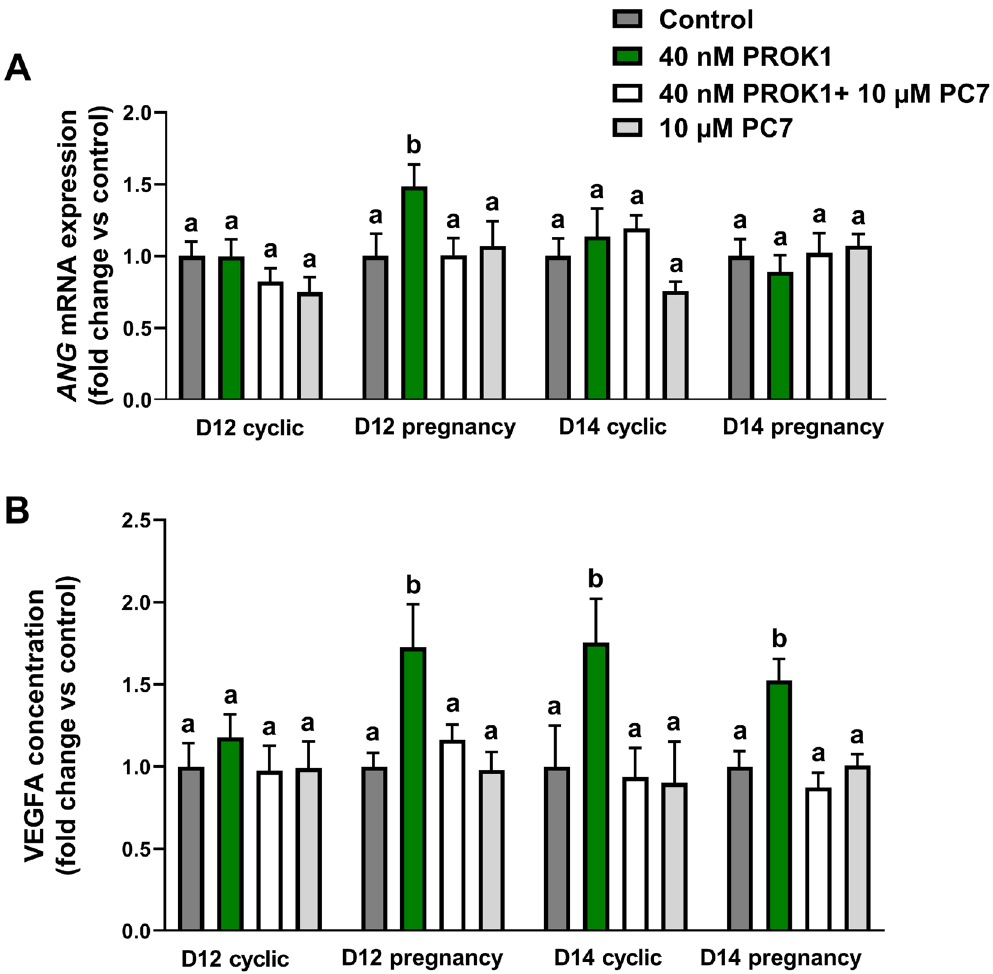
Figure 7. The effect of prokineticin 1 (PROK1) on ( A ) mRNA expression of angiogenin ( ANG ) and ( B ) on vascular endothelial growth factor A (VEGFA) secretion. Precision-cut luteal slices were incubated with control (vehicle) or PROK1 (40 mM) for 18 h in the presence/absence of prokineticin receptor 1 (PROKR1) antagonist (PC7; 10 µM). Data are presented as means ± SEM. Different lowercase letters (a, b) indicate statistical significant differences between treatments within groups on Days 12 (D12) and 14 (D14) of the estrous cycle or